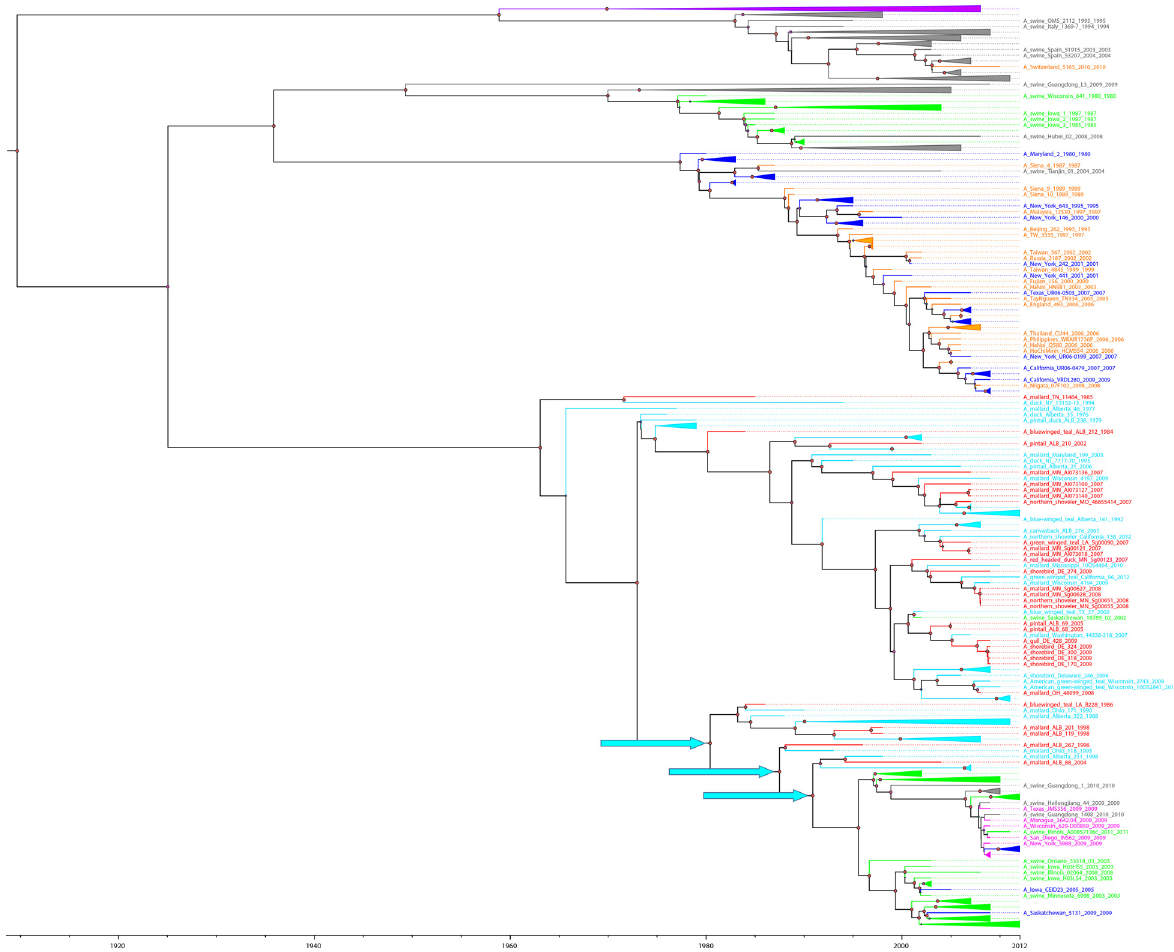
Fig 1. Evolutionary relatedness of PB2 gene segments of H1N1 IAVs of avian, swine, and human origins isolated from North America and Eurasia. The taxa are colored based on their host and geography: red-North American avian isolates from the St. Jude repository, light blue-North American avian isolates, purple-Eurasian avian isolates, green- swine isolates from North America, grey- swine isolates from Eurasia (both Eurasian avian-like swine and Eurasian classical swine), dark blue-human isolates from North America; orange- human isolates from Eurasia, and pink- 2009 pandemic isolates. The nodes with spillover avian H1N1 IAVs are denoted with light blue